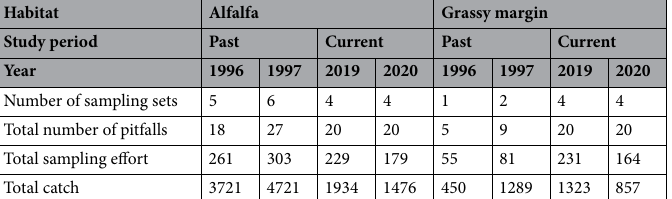
Habitat Alfalfa Grassy margin